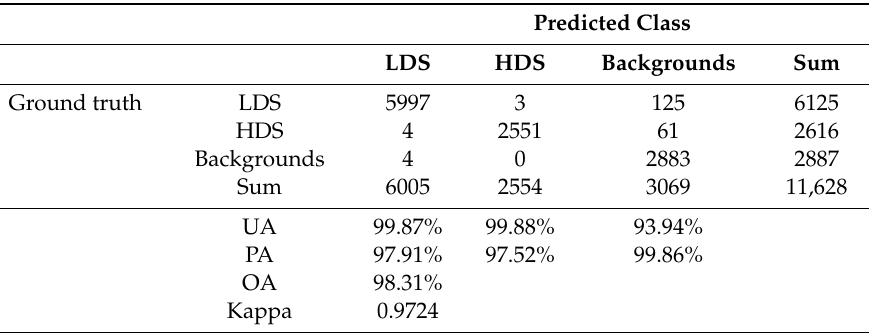
Table 2. Confusion matrix of point test